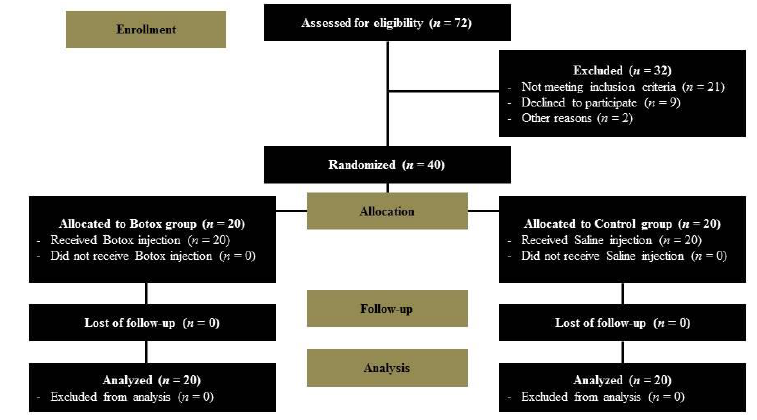
Figure 1. Flow chart of the clinical trial. Table 1. Demographic data of the patients (N =